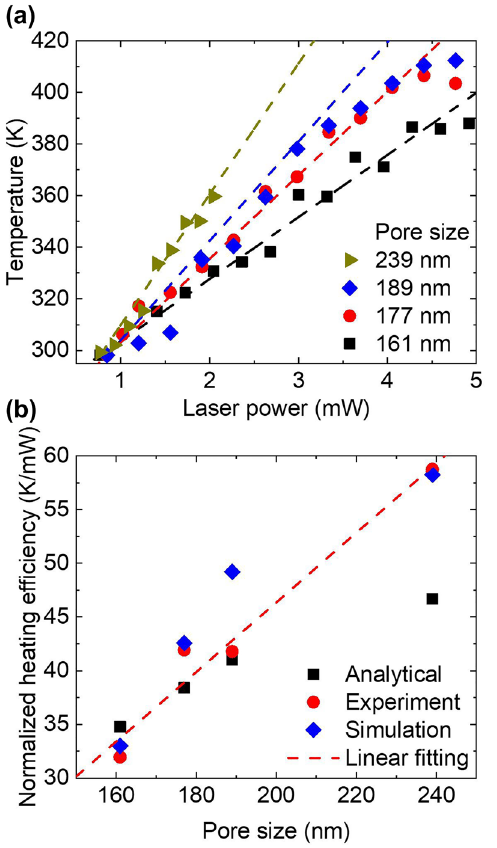
Figure 4: Temperature measurements and heat transfer analyses of photothermally heated TiN-AAO samples. (a) Laser-power-dependent temperature increase from experiments (symbol) and simulations (dashed line). (b) Photothermal heating efficiency of the experiment, simulation, and analytical data where heating efficiency is the slope of power-dependent temperature normalized by absorptance. In subpanels (a) and (b), the TiN-AAO samples were pore-widen for 1 h. The linear fitting in subpanels (b) were fitted from the experiment